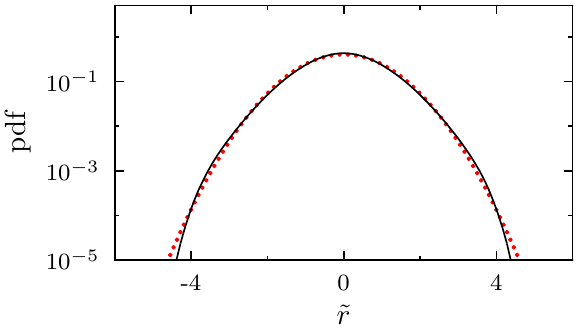
Figure 3. Aggregated distribution of normalized returns ˜ r for fixed covariances from the S&P 500 dataset, ∆ t = 1 trading day and window length T = 25 trading days. The circles show a normal distribution. Reproduced with permission from (Schmitt et al. 2013),